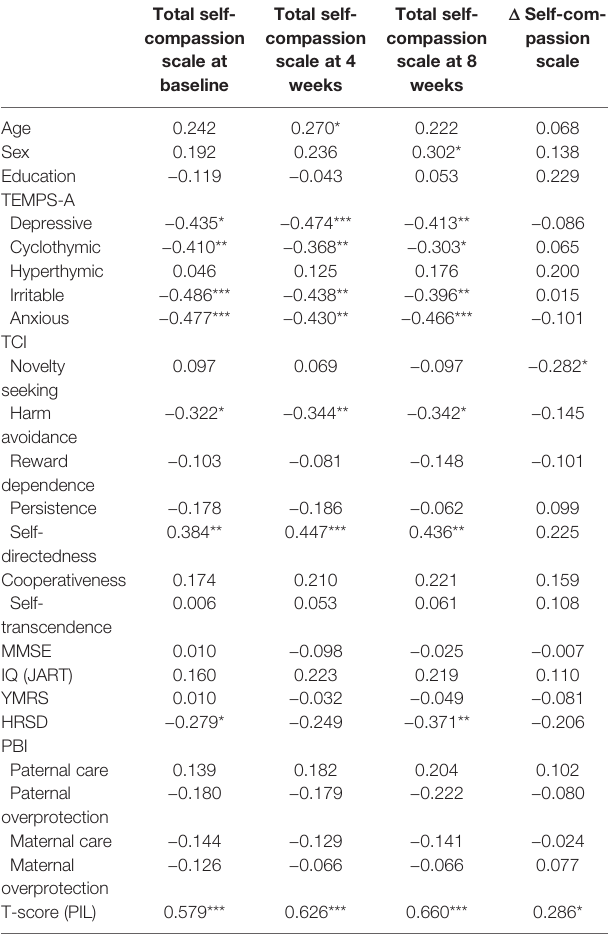
TABLE 2 | Associations of total self-compassion scale scores with relevant factors.